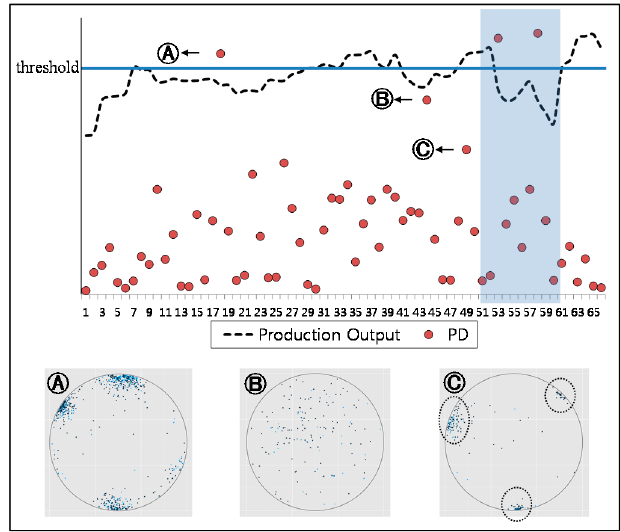
Figure 7. Illustration of the conventional monitoring method. PD , particle defect.